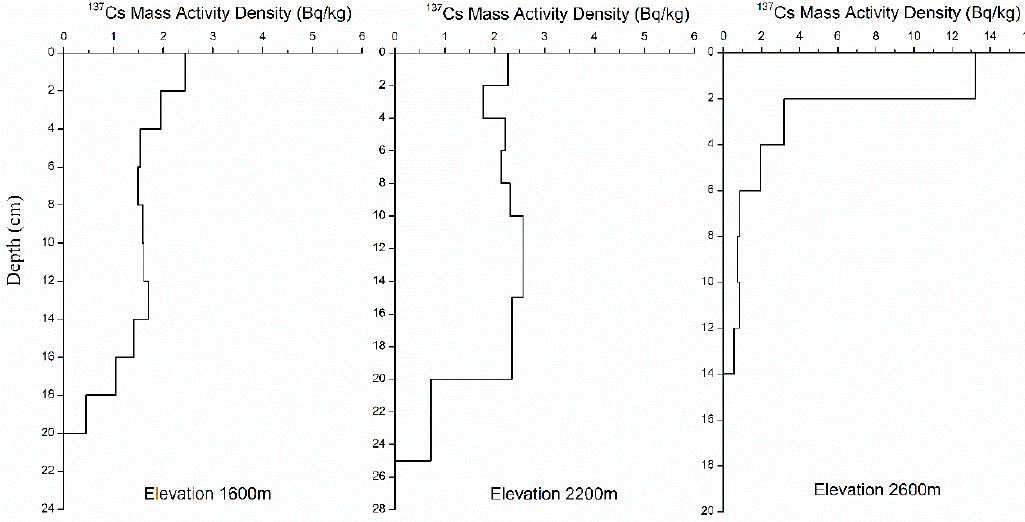
Figure 3. The depth distribution of 137 Cs reference inventories (where 1600 m, 2200 m, and 2600 m represent the elevations of 137 Cs reference locations).